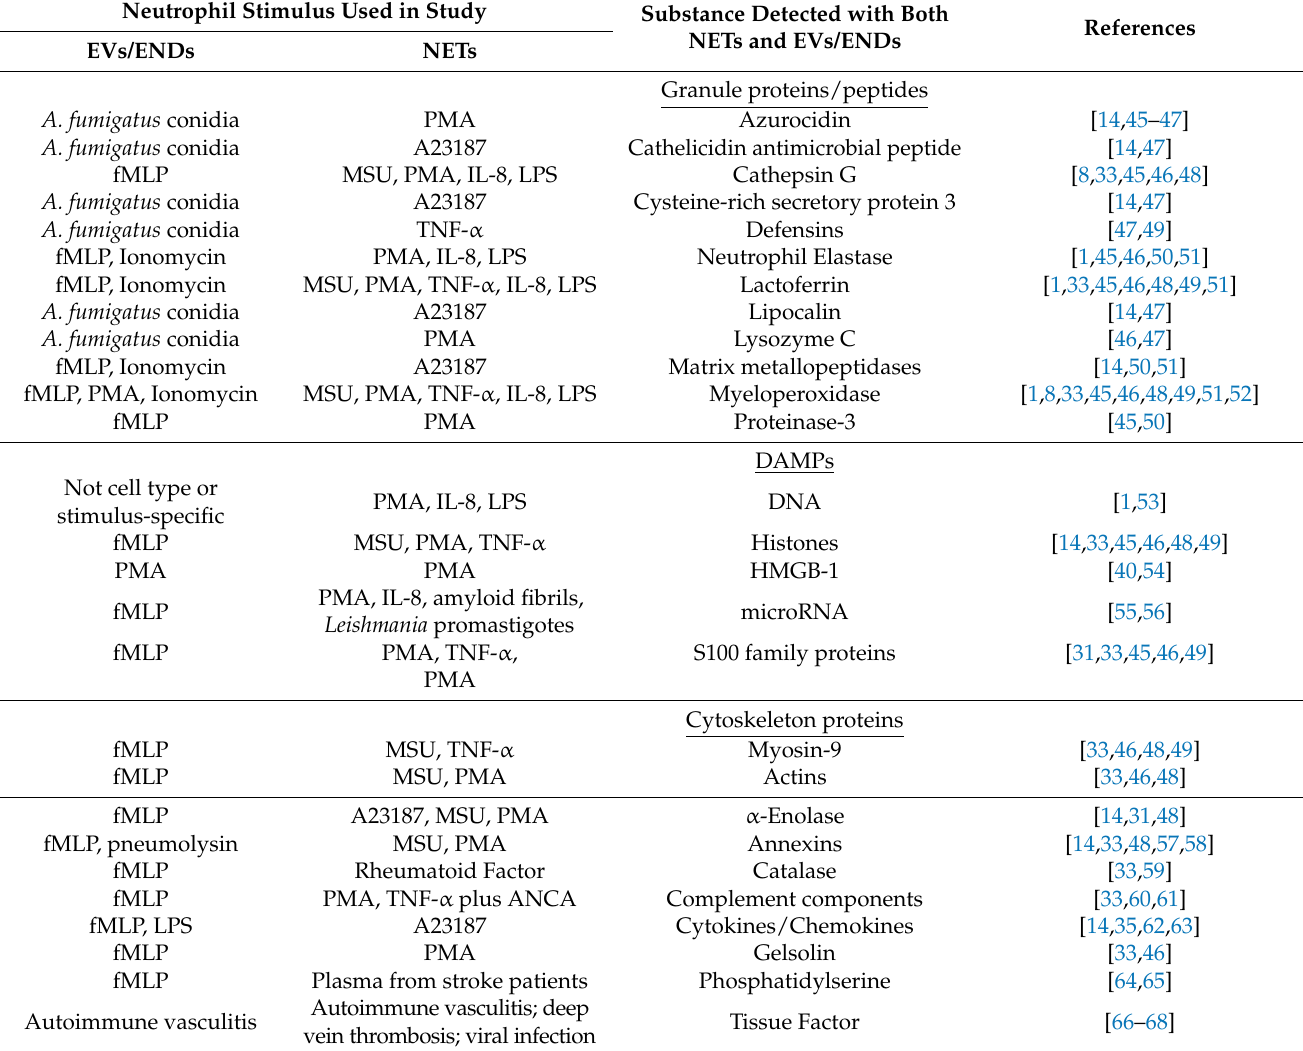
Table 1. Major substances shared by NETs and EVs/ENDs upon stimulation with various priming or activating